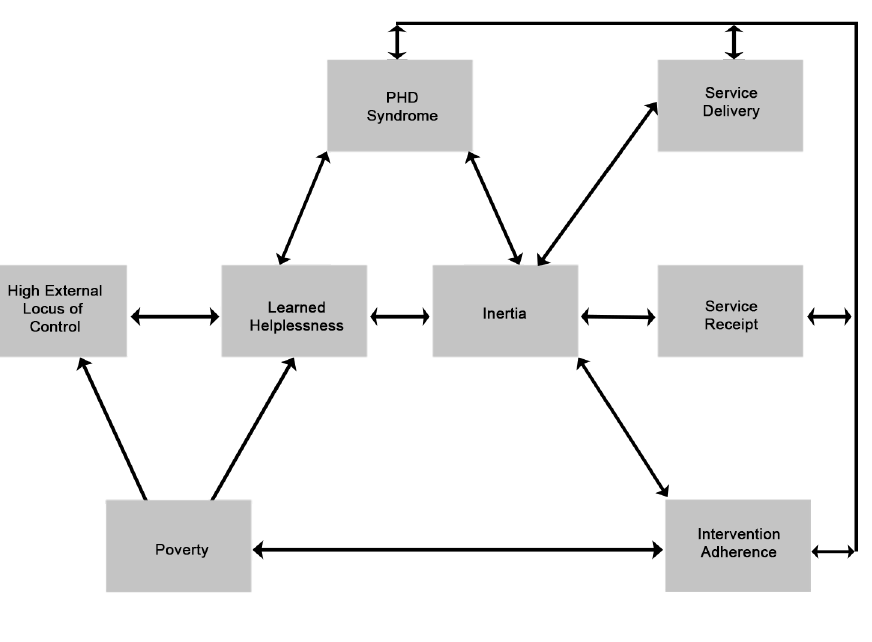
Figure 1. Conceptual links between the Pull-Him/Her-Down (PHD) syndrome, poverty, locus of control, learned helplessness, inertia, and intervention